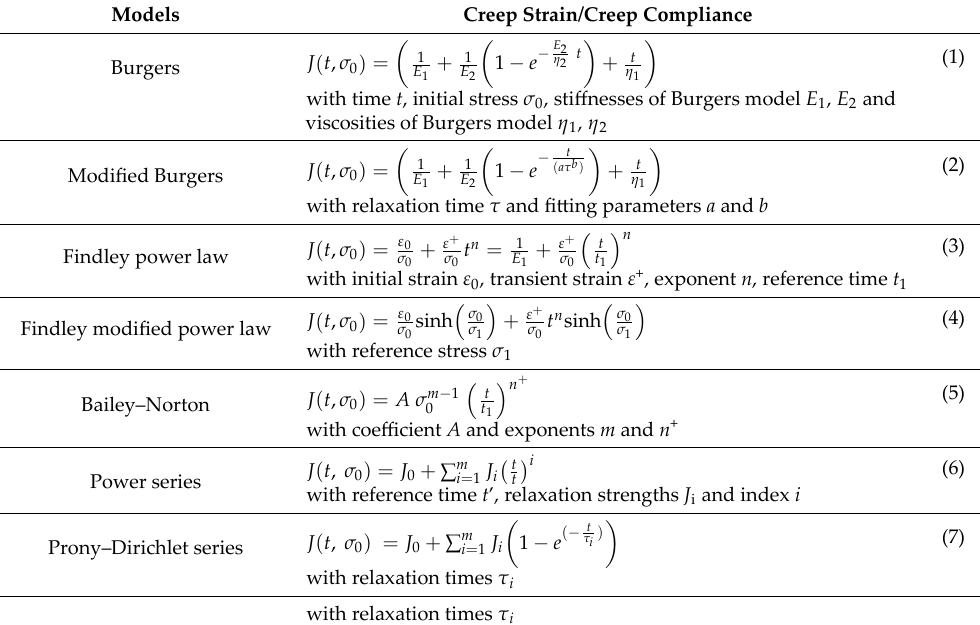
Table 1. Some models of time‑ and stress‑dependent creep compliances for polymers.